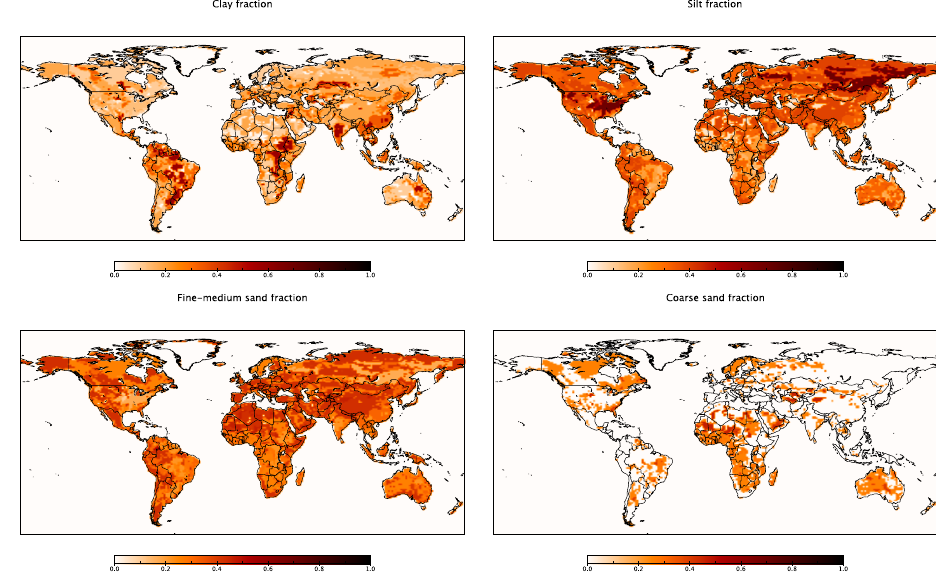
Fig. 2. Clay, silt, fine-medium sand and coarse sand mass fractions based on the soil textures of the hybrid STATSGO-FAO soil map. Table 1 provides the mass fractions of clay, silt, fine-medium sand and coarse sand for each soil texture class estimated from the textural triangle.